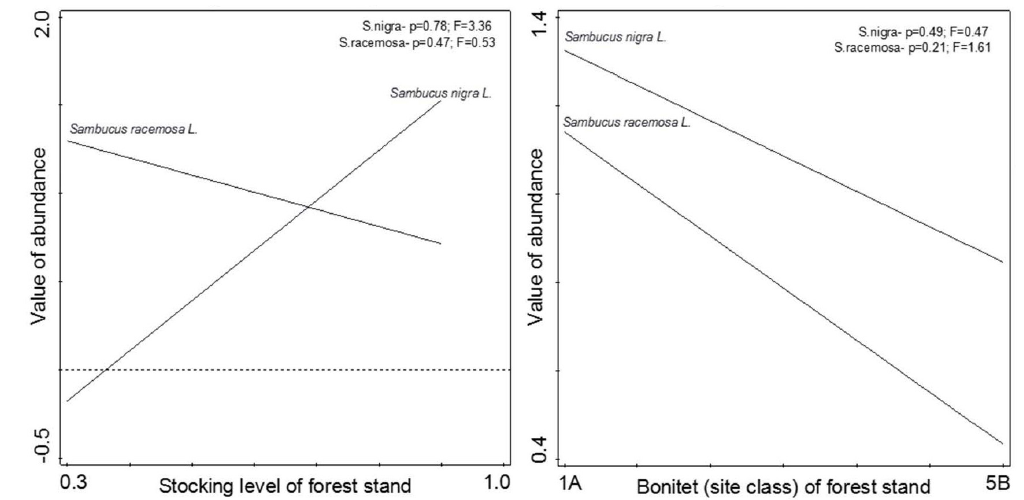
Figure 11. The results of generalized linear regression method (GLM) analysis between Sambucus racemosa, S. nigra and stand dendrometric parameters (height, stocking level, bonitet and age of forest stand)